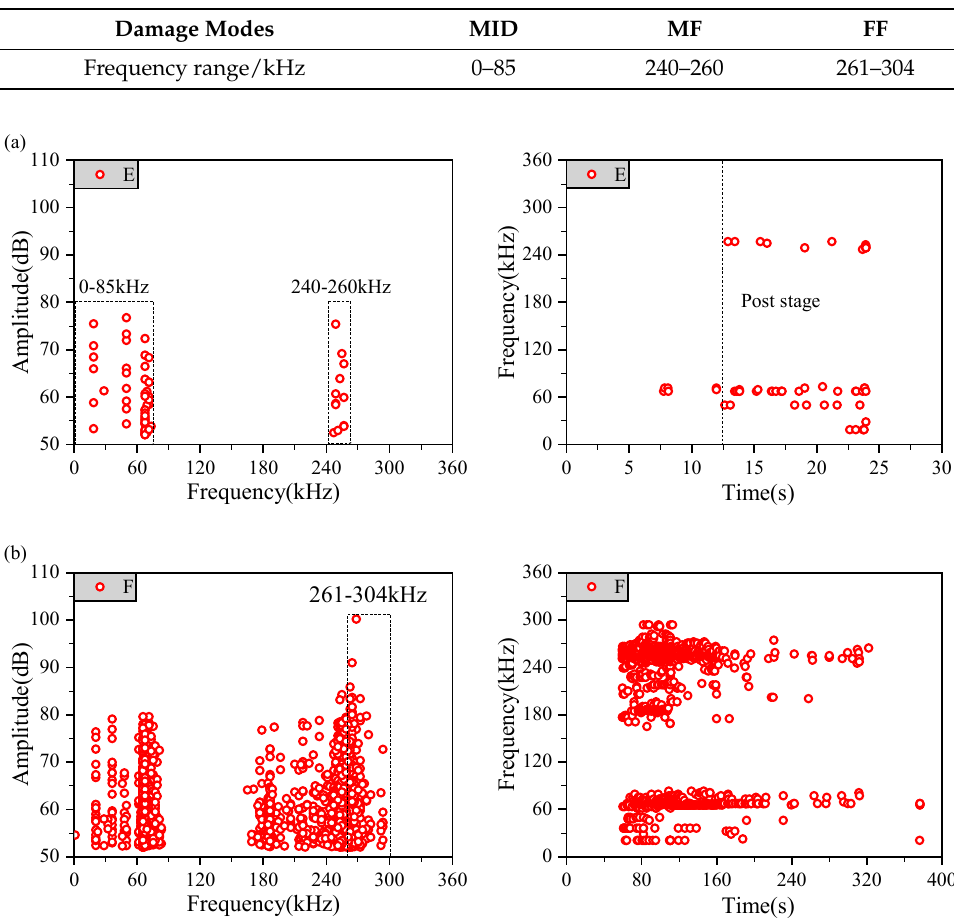
Table 3. Specific frequencies corresponding to various damage modes.